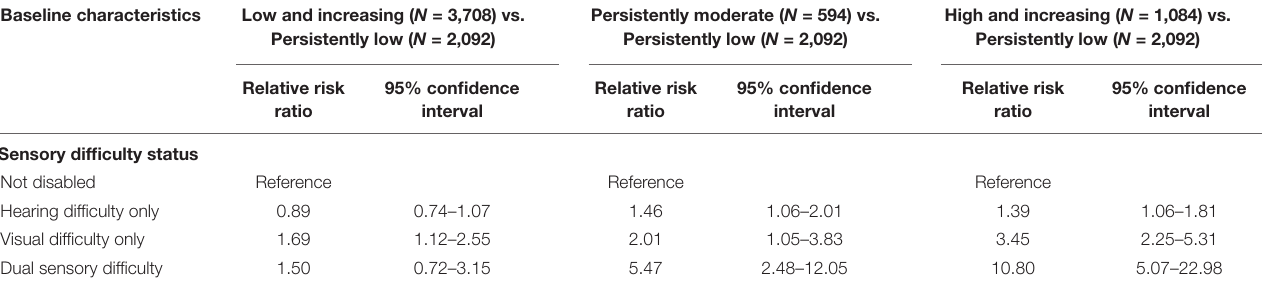
TABLE 3 | Multivariable multinomial logistic regression predicting depressive symptom trajectory group as a function of sensory difficulty status and other characteristics. Baseline